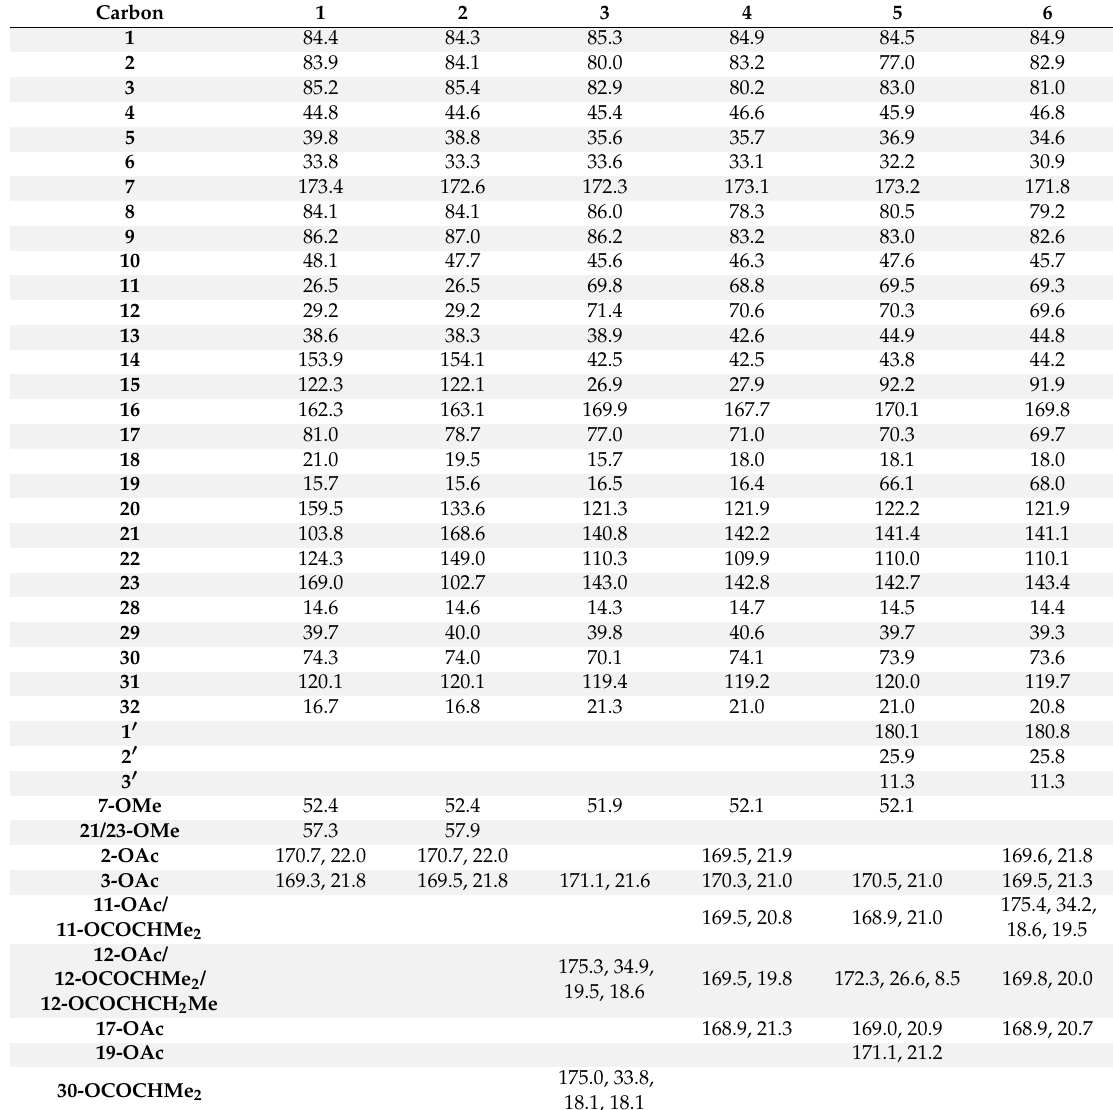
Table 2. 13 C-NMR (125 MHz) data of compounds 1 – 6 (CDCl 3 , δ C in ppm).